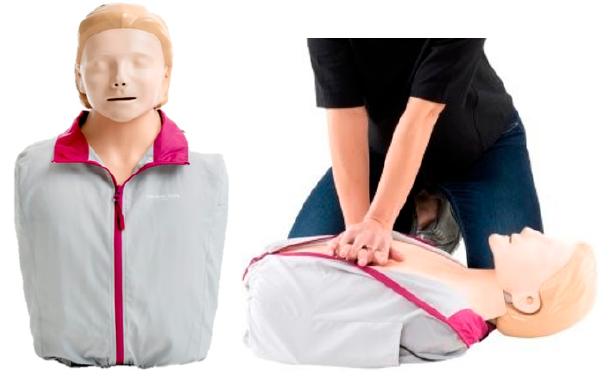
Figure 2. The manikin module of Resusci